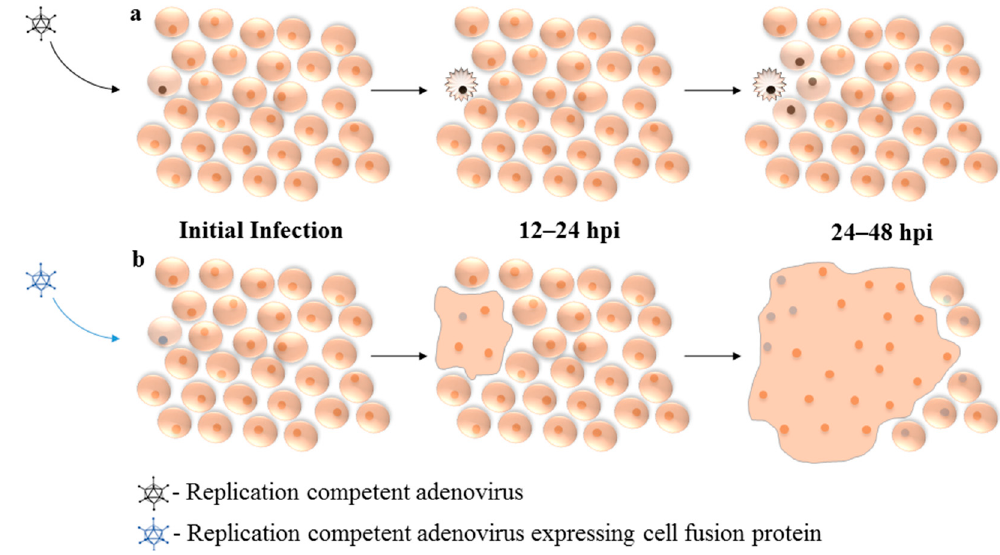
Figure 2. Mechanism of enhanced viral spread through expression of fusogenic protein: ( a ) Upon infection, replication ‐ competent oncolytic adenovirus (Ad) must undergo productive replication and significantly damage the host cell in order to affect neighboring cells. ( b ) Cell ‐ fusion proteins allow Ad to spread through densely packed cells with much greater efficiency, before replication ‐ associated cell death or progeny release. Initial Infection: Virus enters host cell and initiates gene expression and early phase of replication. 12–24 hpi: Viral protein expression and progeny production. 24–48 hpi: Viral progeny released from initially infected cell, enter nearby cells. hpi: hours post ‐ infection.